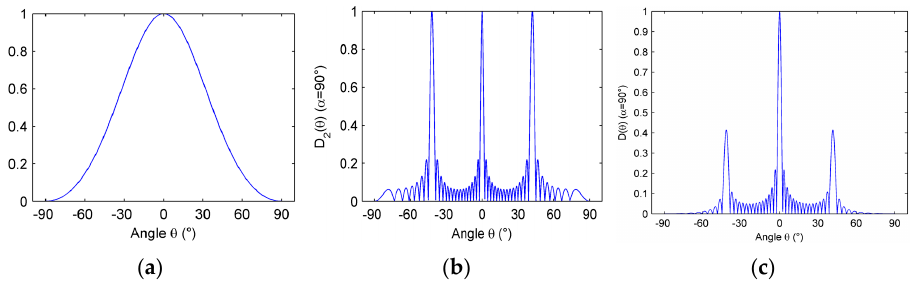
Figure 6. Directivity pattern of function ( a ) D 1 p θ q , ( b ) D 2 p θ q ; and ( c ) D p θ q in y-z plane.